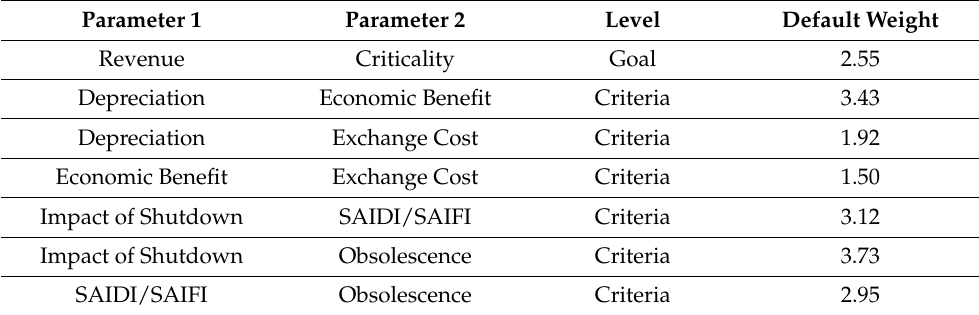
Table 5. Description of the AHP model weights database in this work.